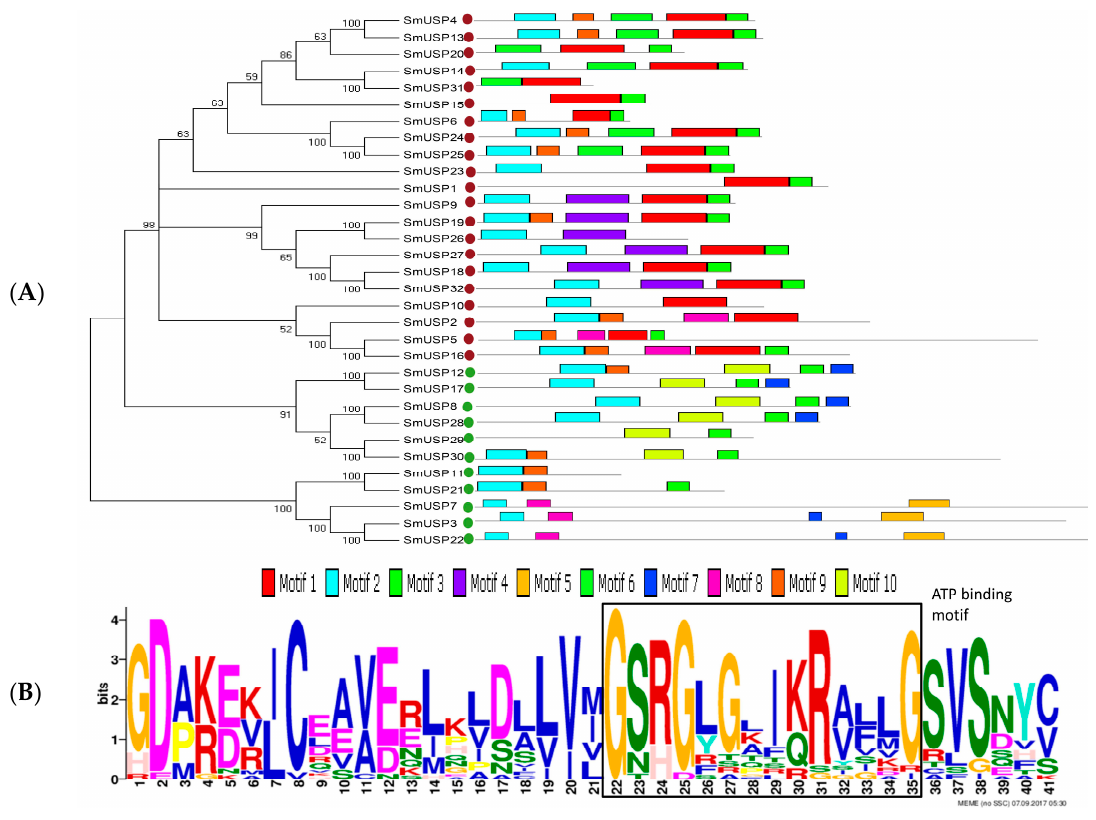
Figure 2. Conserved motifs of SmUSP. ( A ) Conserved motifs and phylogenetic tree of 32 SmUSPs. Red spots, members of ATP-binding class; green spots, members of non-ATP-binding class; ( B ) ATP-binding motif (G-2X-G-9X-G[S/T]) is